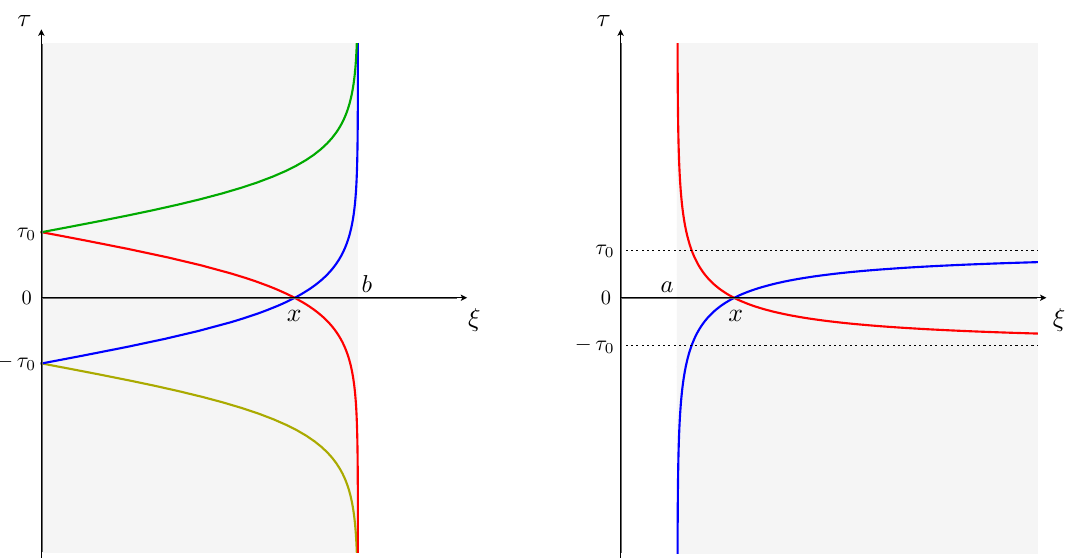
Figure 2 . Modular evolution through the arguments of the fields for a point x at τ = 0 when A = [0 , b ] (left panel, see (7.8)) and when A = [ a, + ∞ ) (right panel, see (7.13)), discussed in section 7.2 and in section 7.3